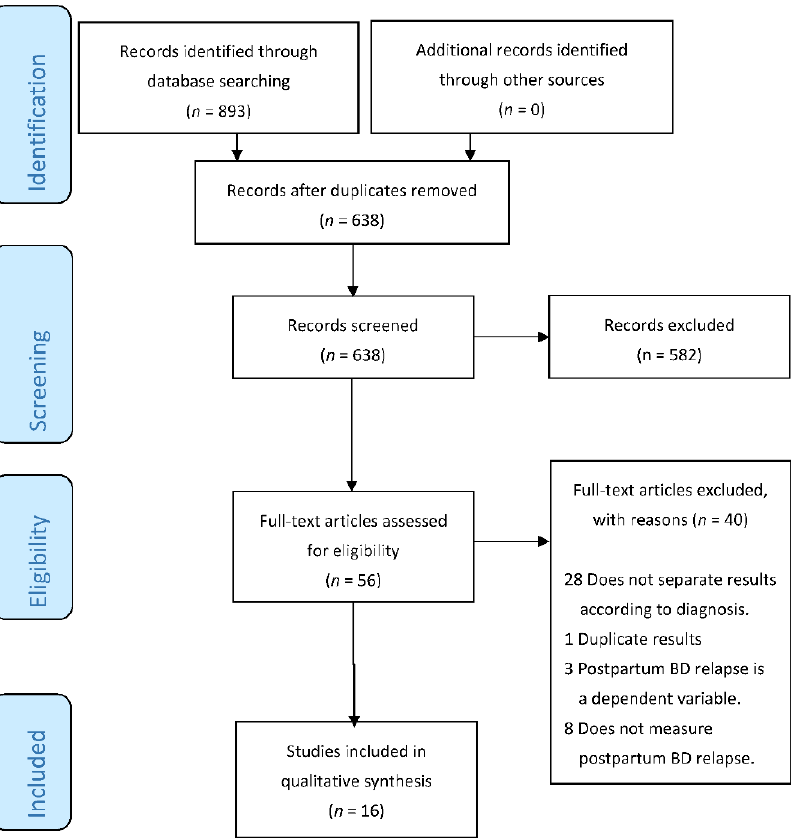
Figure 1. Preferred Reporting Items for Systematic Reviews and Meta-Analyses (PRISMA) flow diagram. Table 1. Results of studies estimating the prevalence of postpartum relapse in patients with bipolar disorder.